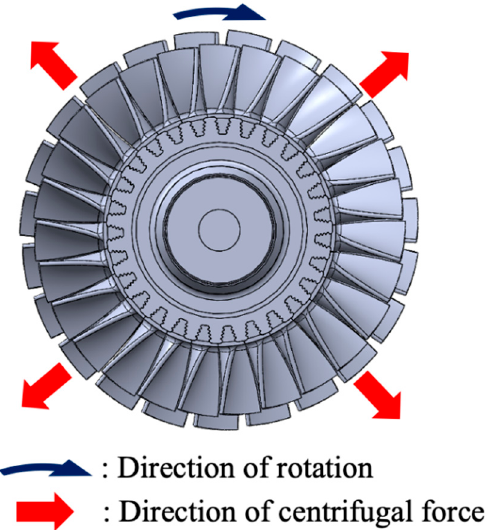
Figure 2. Centrifugal force resulting from rotor blades of TRT rotor in operation .